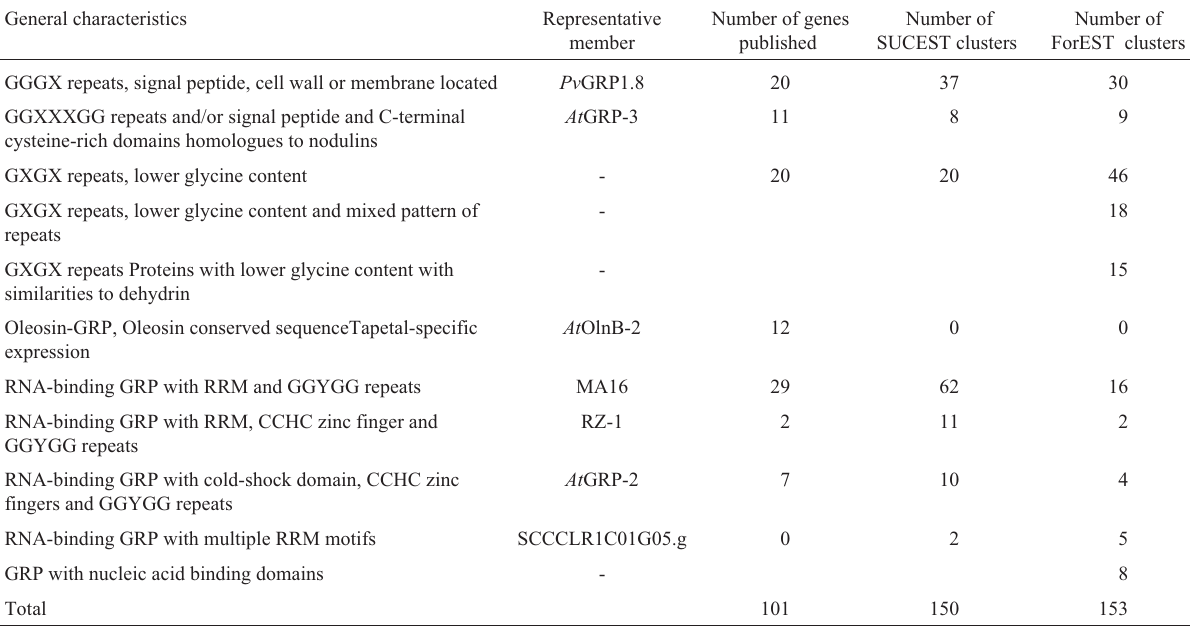
Table 1 - Distribution of glycine-rich protein genes on ForEST